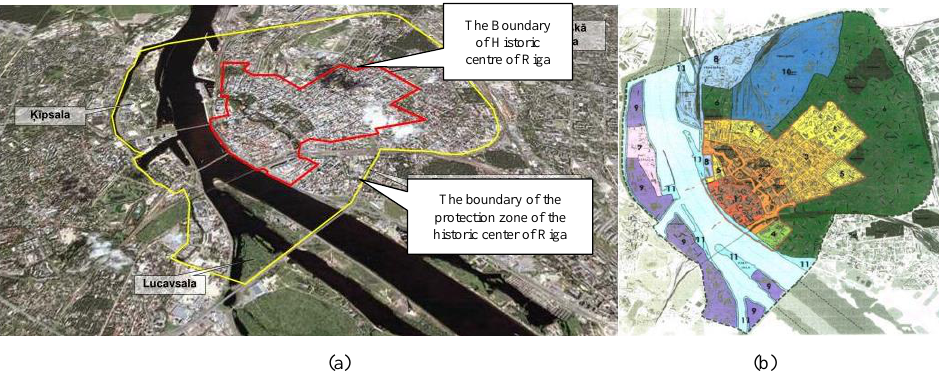
Fig. 3. (a) Riga Historic Centre in the context of the city [36]; (b) zoning in Riga Historic Centre and its protection zone